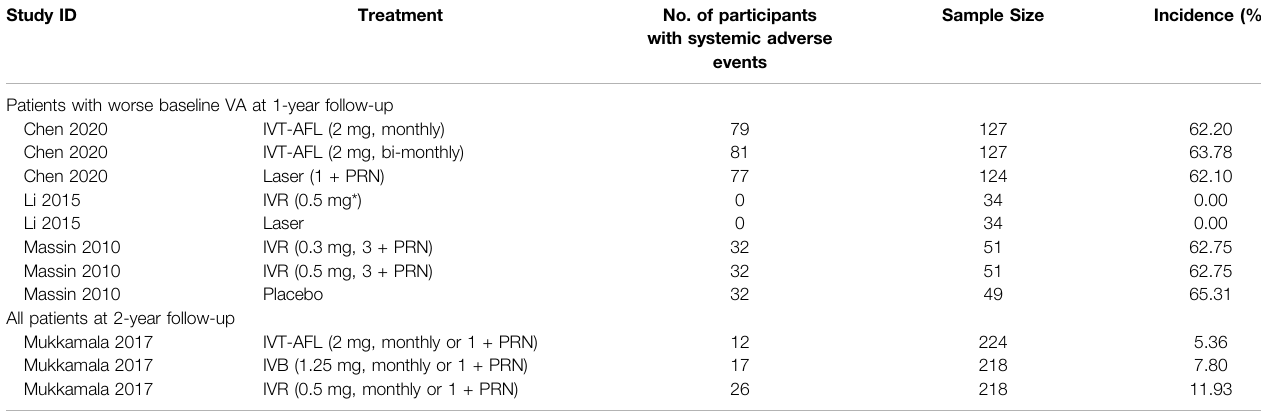
TABLE 6 | Incidence of systemic adverse events.